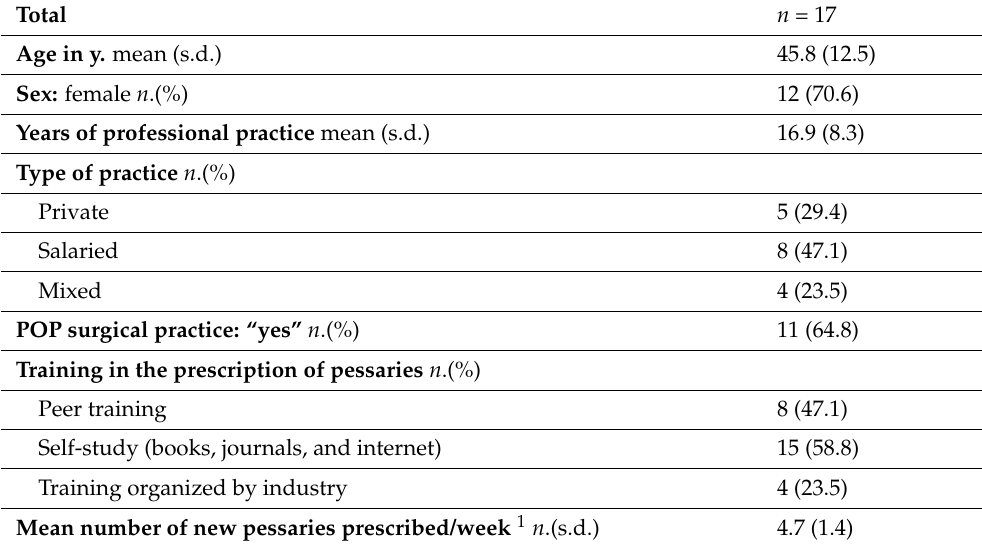
Table 1. Characteristics of the professionals questioned in semi-directive